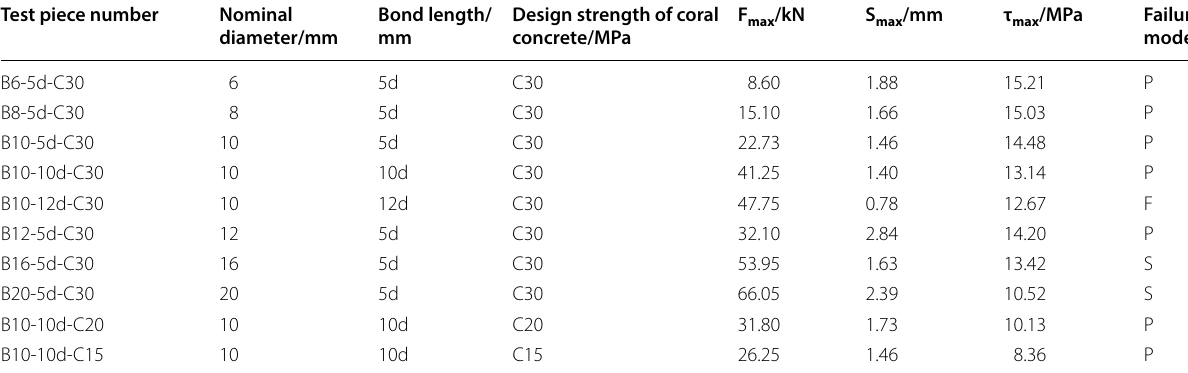
The meaning of each symbol in the table: “d” denotes the diameter of BFRP rebar, “F max ” denotes the ultimate bonding force; “S max ” denotes the amount of slip of the BFRP rebar when the maximum pulling force is reached; “τ max ”denotes Average bond stress at maximum pull force; Destructional forms: “P” denotes pull-out failure, “F” denotes fracture failure, “S” denotes splitting failure. The data listed in the table are represented by the results of the three specimens in each group with its closest to the average value of their maximum drawing force.